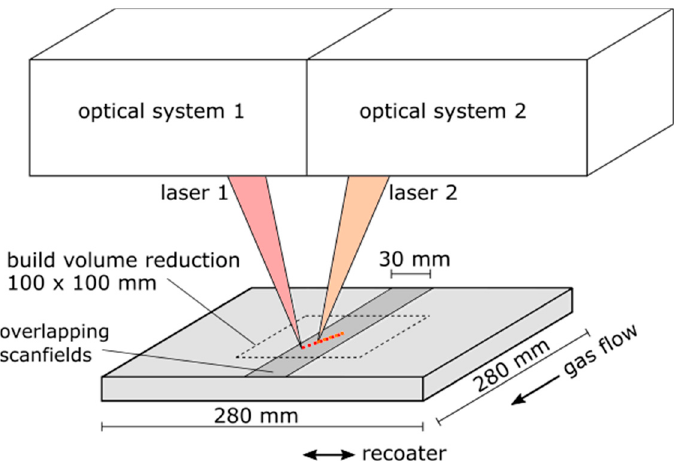
Figure 1. Illustration of the PBF-LB system configuration to achieve dual-laser processing.